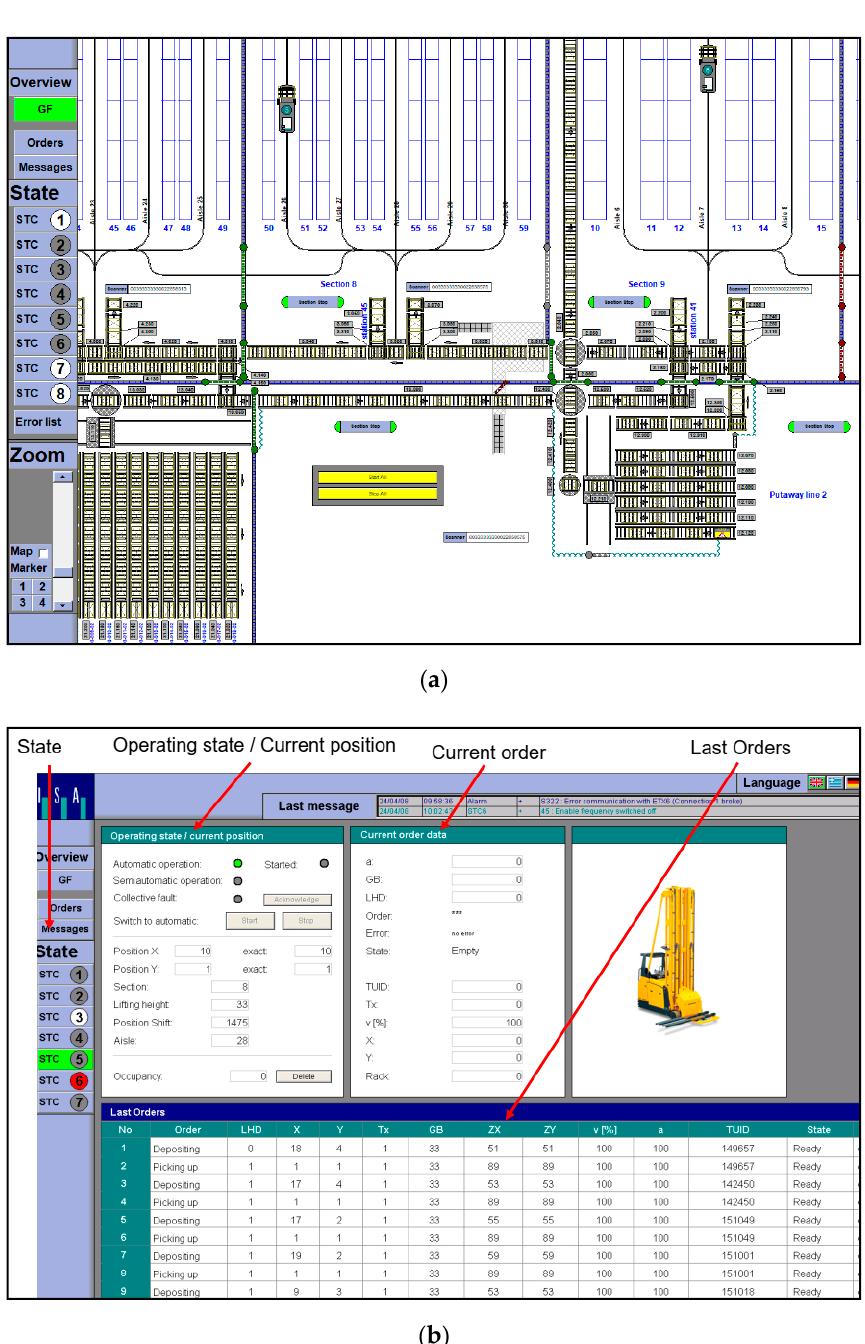
Figure 5. Human Machine Interface (HMI) WinCC. ( a ) some examples of the plant visualization, ( b ) the interface that is used by the users.